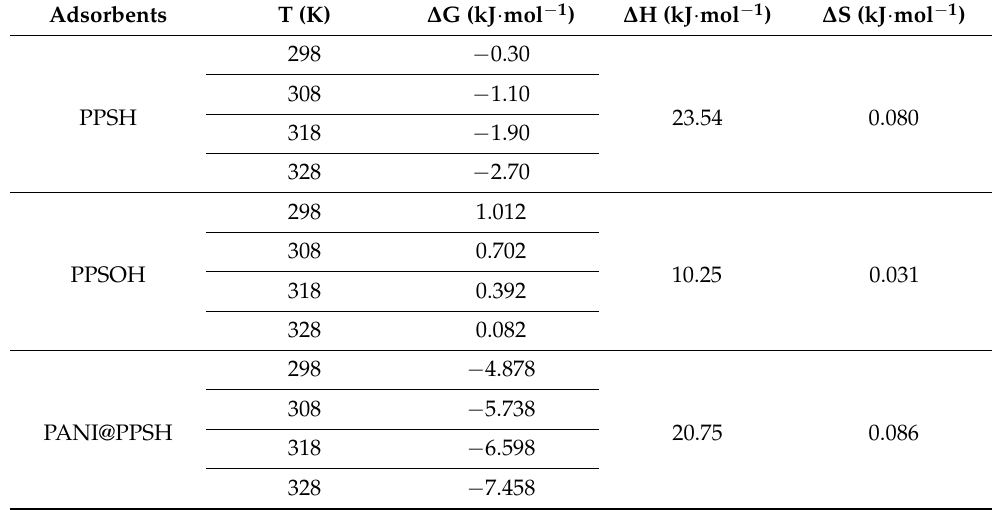
Figure 6. ( a ) Influence of temperature on elimination percentage and ( b ) cyclic adsorption–desorption performance of adsorbents on CR (C 0 : 20 mg·L − 1 ; adsorbents dose: 0.1 g; CR: 100 mL; T: 298 K; pH 6.5). Table 5. Thermodynamic data for CR adsorption by the three adsorbents prepared.